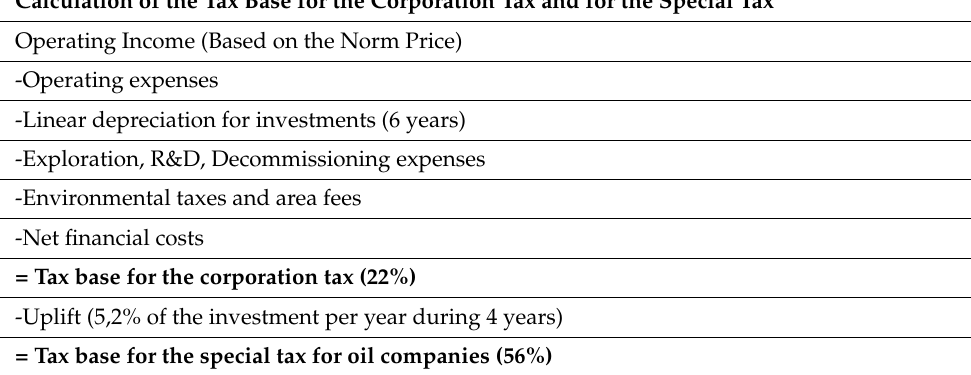
Table 3. Tax base calculation example